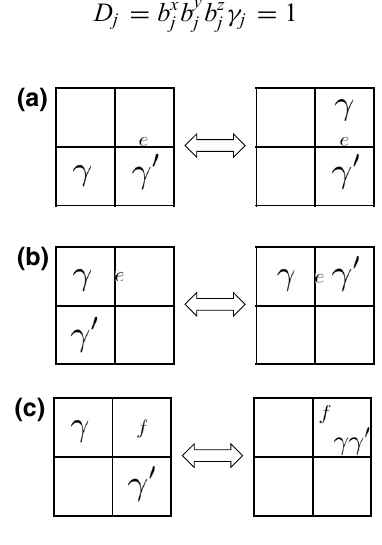
FIG. 15. Correspondence of logical operators between the exact bosonization and the Verstraete-Cirac mapping.